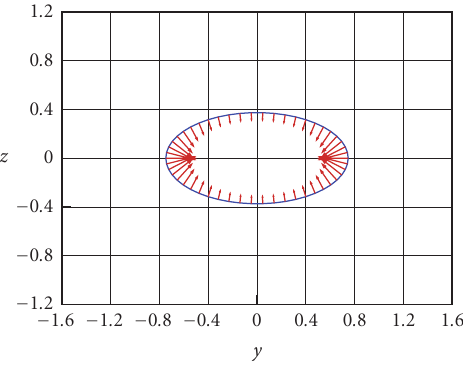
Figure 6.3. Normal stress ( T nn n y + T nn n z ) / 300dyn/cm 2 for an ellipse y 2 /b 2 + z 2 /c 2 = 1 − 2 . 6 2 /a 2 at x = − 2 . 6 cm in the ( y , z )-plane. Perpendicular view of the cross section (b) in Figure 6.1. There is a bigger compression (indicated by bigger inwards arrows) at the right and left poles of the ellipse. This may cause that the cross section of the ellipsoid becomes more round and in consequence the ellipsoid would tend to be